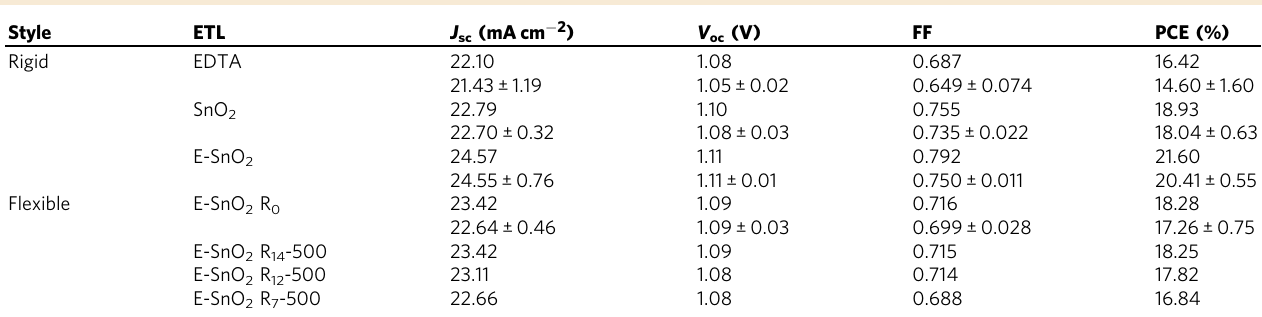
Table 1 The parameters of the rigid and fl exible